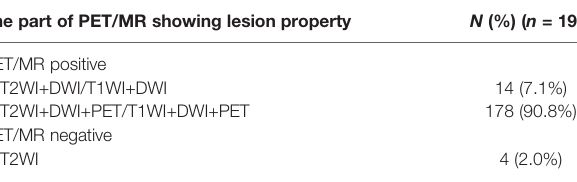
TABLE 4 | The part of PET/MR showing the lesion property in liver metastases detection. The part of PET/MR showing lesion property PET/MR positive T2WI+DWI/T1WI+DWI